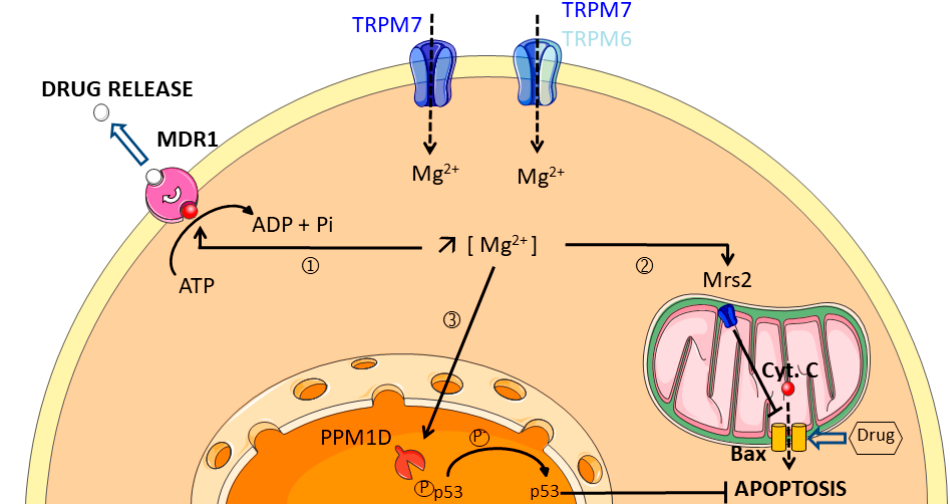
Figure 4. Multidrug resistance is associated with an increase of intracellular free Mg 2+ . Intracellular free Mg 2+ could promote multidrug resistance through three main potential mechanisms: ① Mg 2+ binds to MDR1 leading to drug extrusion; ② Mg 2+ enters into the mitochondria through Mrs2 channel leading to Bax inhibition and resistance to apoptosis, ③ Mg 2+ activates the nuclear PPM1D phosphatase which alters p53 stabilization and protects cancer cells against apoptosis. Chemoresistant cancer cells have a lower Mg 2+ influx and lower amounts of TRPM6 and TRPM7 channels at the plasma membrane.